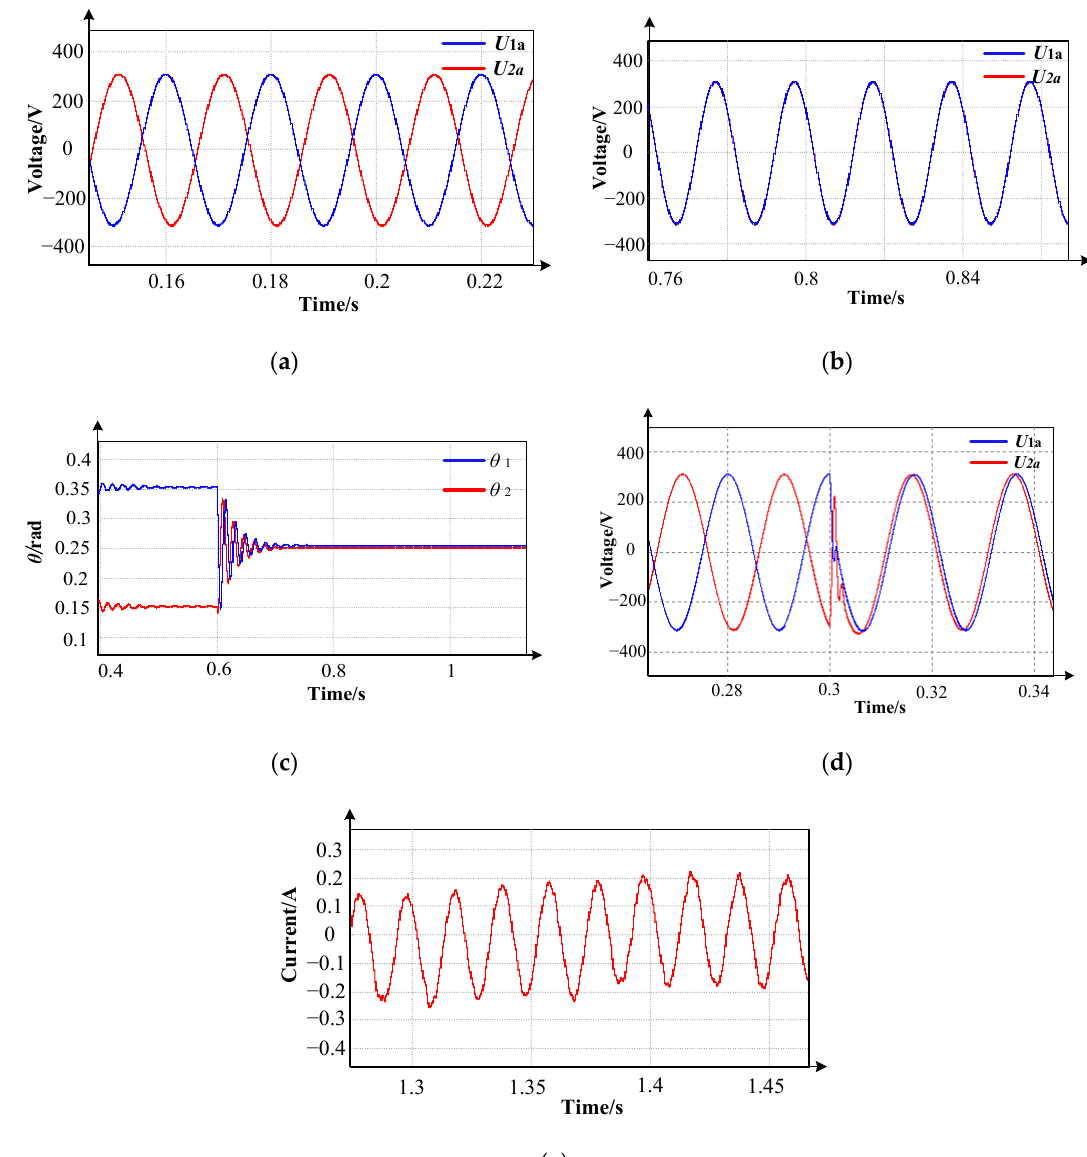
Figure 11. Converter parallel strategy simulation results: ( a ) initial state output voltage; ( b ) steady state output voltage; ( c ) change in phase angle difference; ( d ) transition process; ( e ) steady state circulating current.